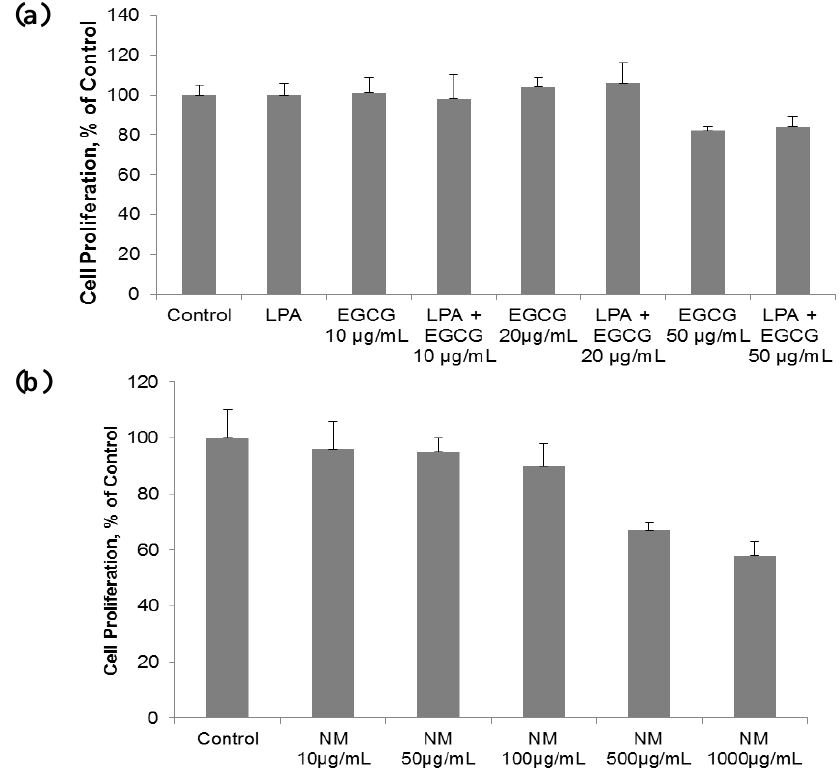
Figure 1. Comparative effect of EGCG, LPA and NM on HepG2 cell proliferation: MTT assay 24 h ( a ) Effect of EGCG with and without LPA on HepG2 cell proliferation; ( b ) Effect of NM on HepG2 cell